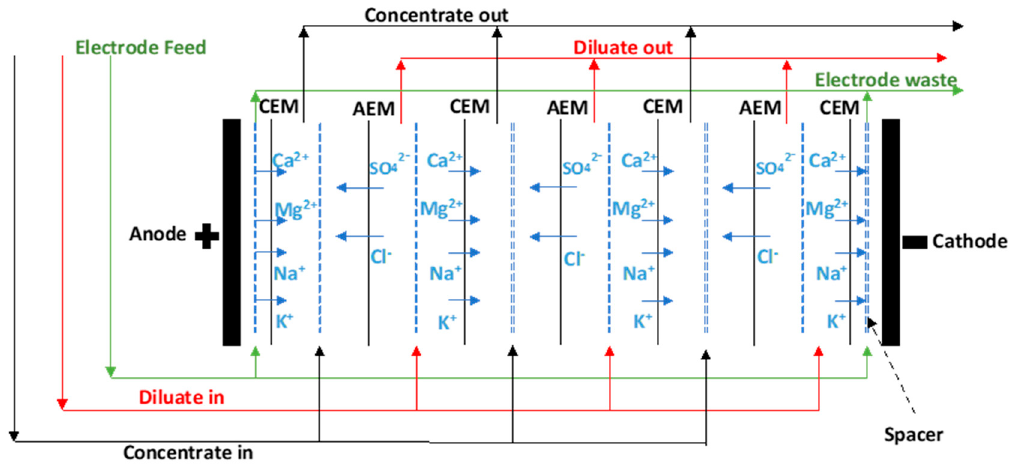
Figure 1. Schematic diagram of electrodialysis stack.